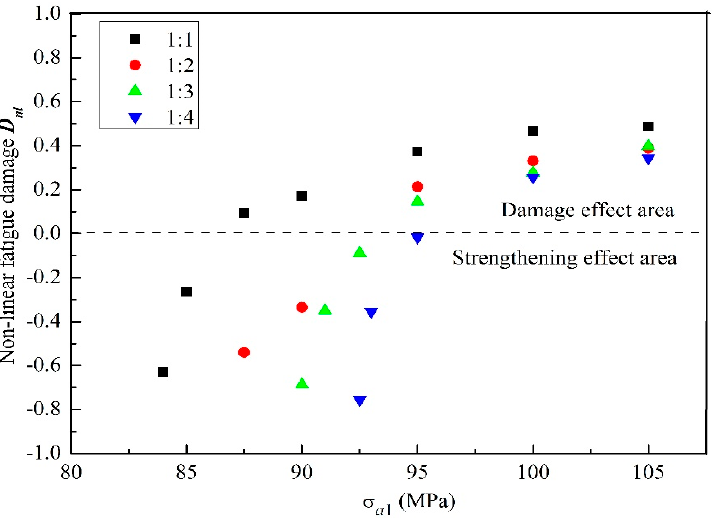
Figure 13. The calculation results of the damage value of load interaction effect D nl .